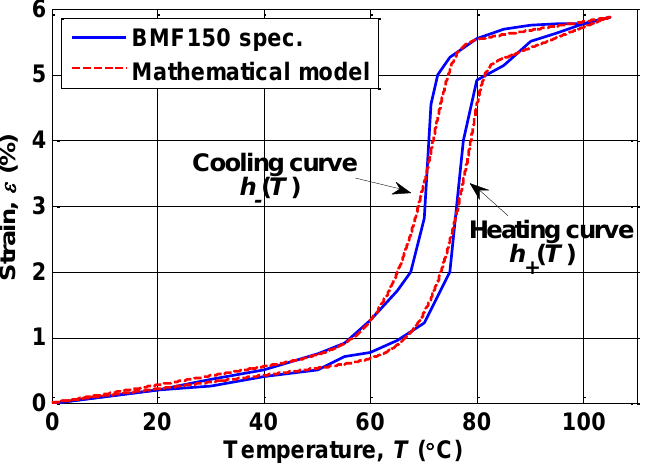
Figure 7. Comparison of the hysteresis of the SMA actuator between the device specifications (solid line) and the modeling result (dashed line).